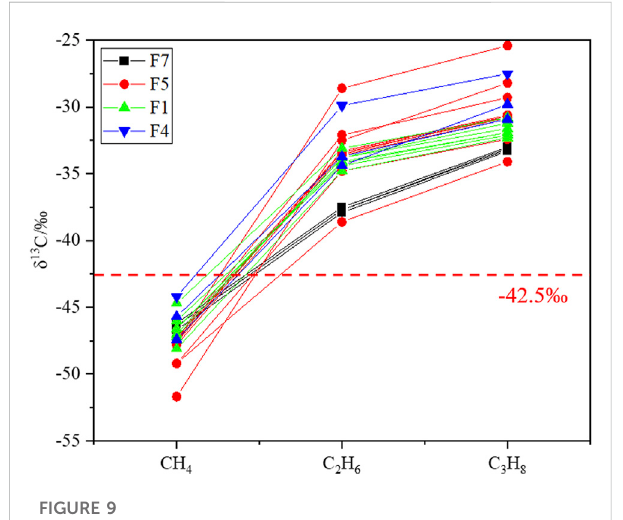
FIGURE 10 Carbon isotope curves of non-hydrocarbon from the Tarim